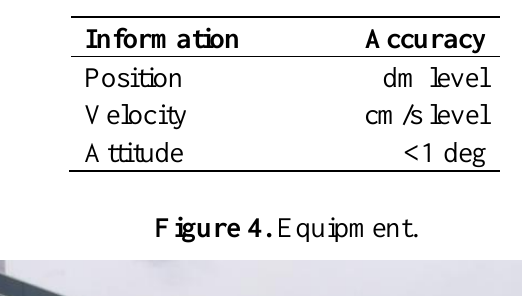
Table 3. Reference solution accuracy.